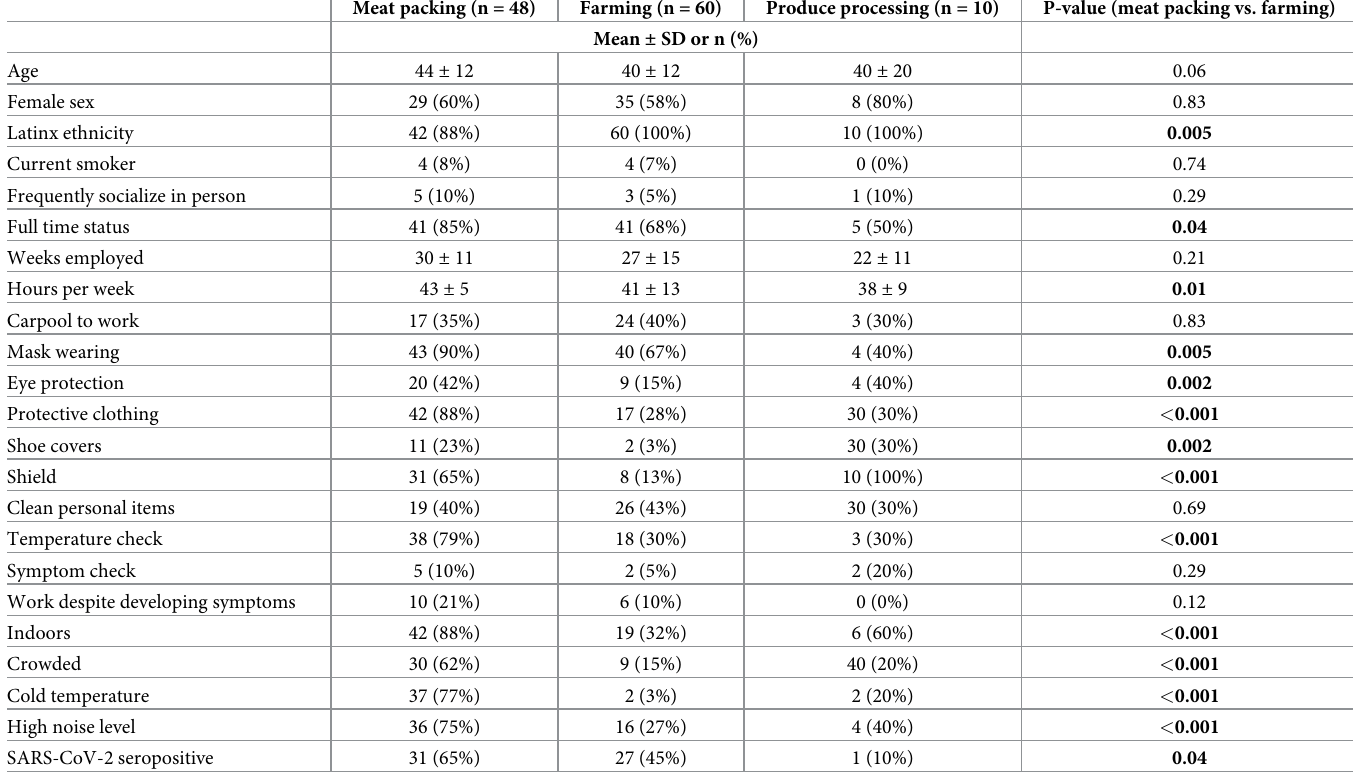
Table 1. North Carolina food processing worker characteristics by industry (fall